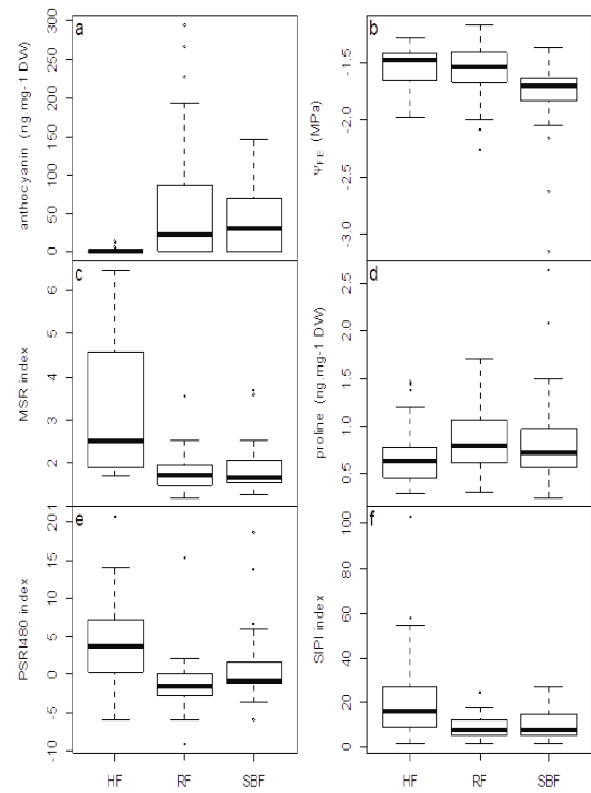
Different letters in rows indicate significant difference between types of